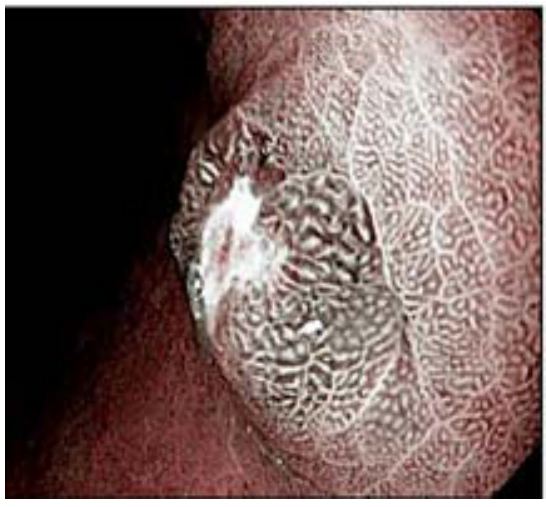
FIGURE 14. Stomach: gastric carcinoid with a central ulceration; narrow-band imaging coupled to magnification. In the antral mucosa the organization of the epithelial crests in large areas separated by deep sulci is